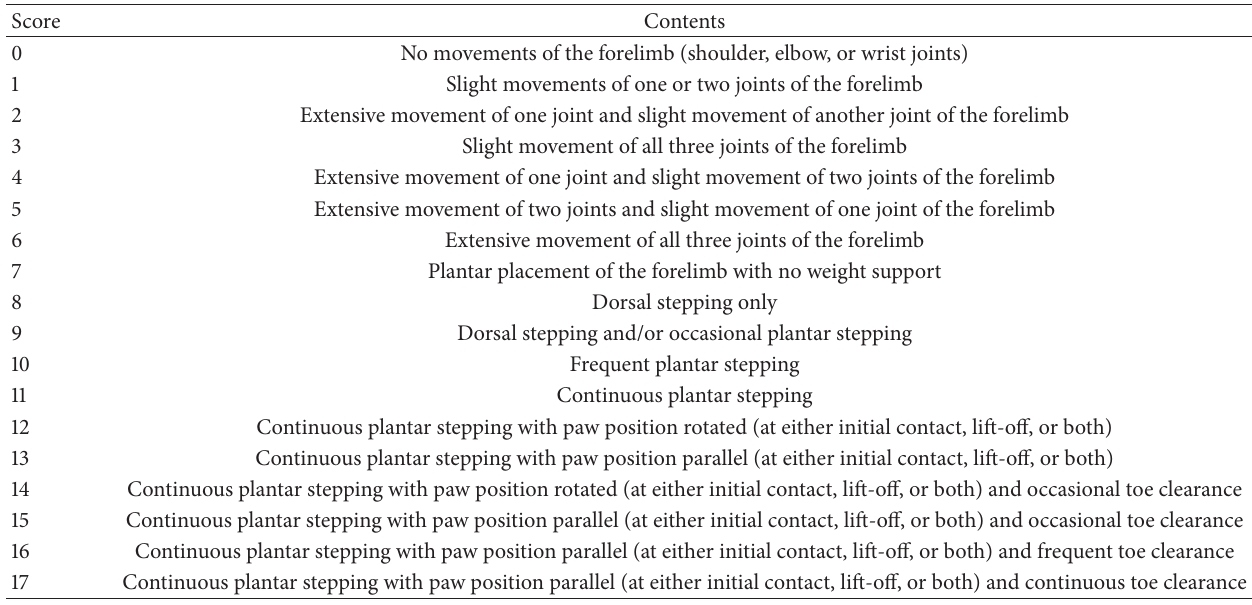
Table 1: Forelimb Locomotor Scale (FLS): methods of scoring.